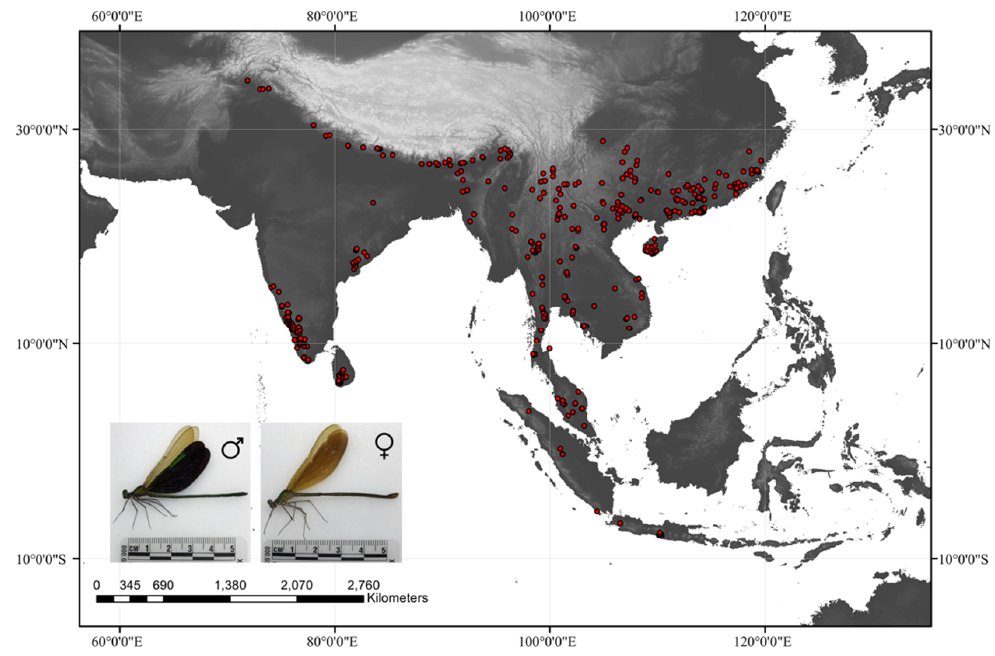
Figure 1. Occurrence records of N. chinensis in the world. Data were obtained from literature, the GBIF database, and our fieldwork. The female N. chinensis in the bottom left was from Nankunshan Provincial Nature Reserve, Guangdong Province, and the male was from Shiwandashan National Forest Park, Guangxi Province. Pictures were both taken by Jian Liao in 2021.